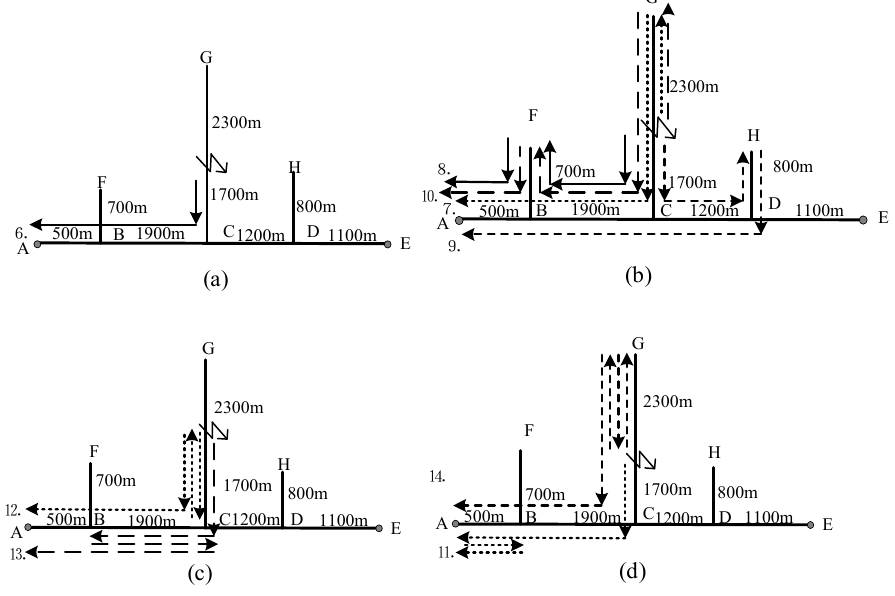
Figure 1. Traveling wave propagation. ( a ) Initial Wave. ( b ) Branch Terminal Reflected Waves. ( c ) Tee Point and Fault Point Reflected Waves. ( d ) Hybrid Reflected Waves.